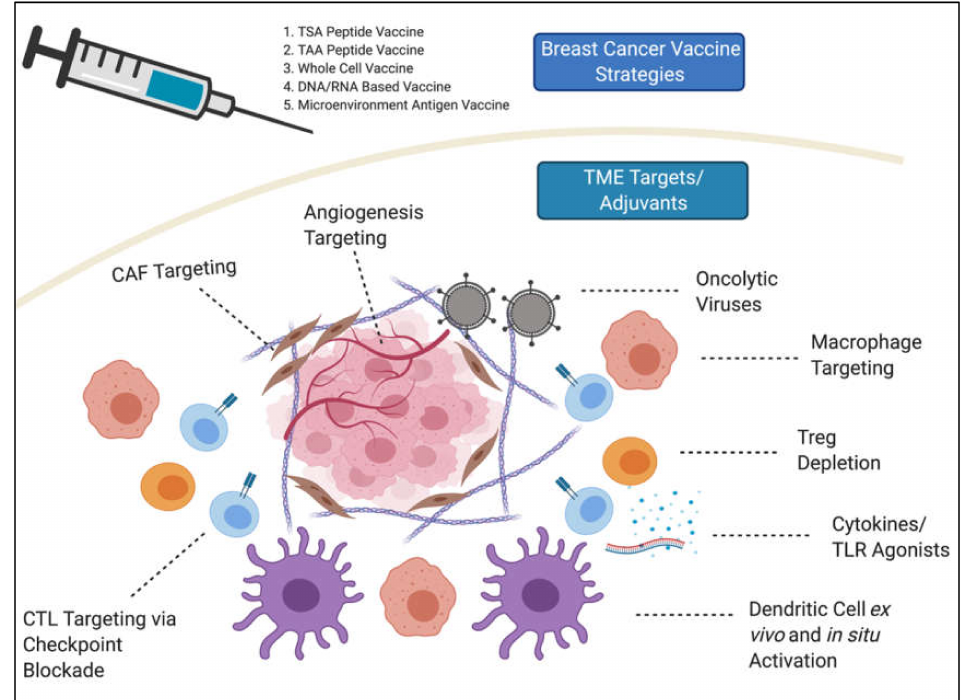
Figure 1. Awakening the tumor microenvironment as a means to increase e ffi cacy of therapeutic breast cancer vaccines. Peptide, nucleotide, and whole cell-based vaccines have been tested for many years but have failed in the clinic partly because of an immunosuppressive tumor microenvironment (TME). Increased understanding of the TME and novel therapeutics to increase anti-tumor immune properties have increased vaccine promise in pre-clinical models. This paradigm is currently being tested in clinical trials. TME, tumor microenvironment; TSA, tumor specific antigen; TAA, tumor associated antigen; CAF, cancer associated fibroblast; Treg, regulatory T-cells; CTL, cytotoxic T lymphocytes; TLR, toll-like receptor. (Figure created with